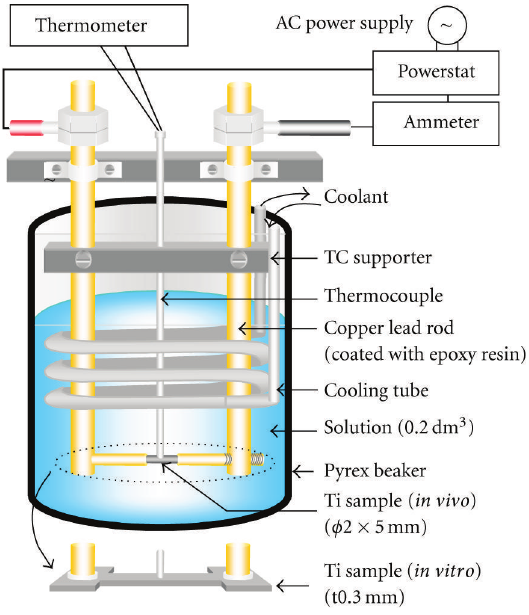
Figure 3: Experimental apparatus for HAp